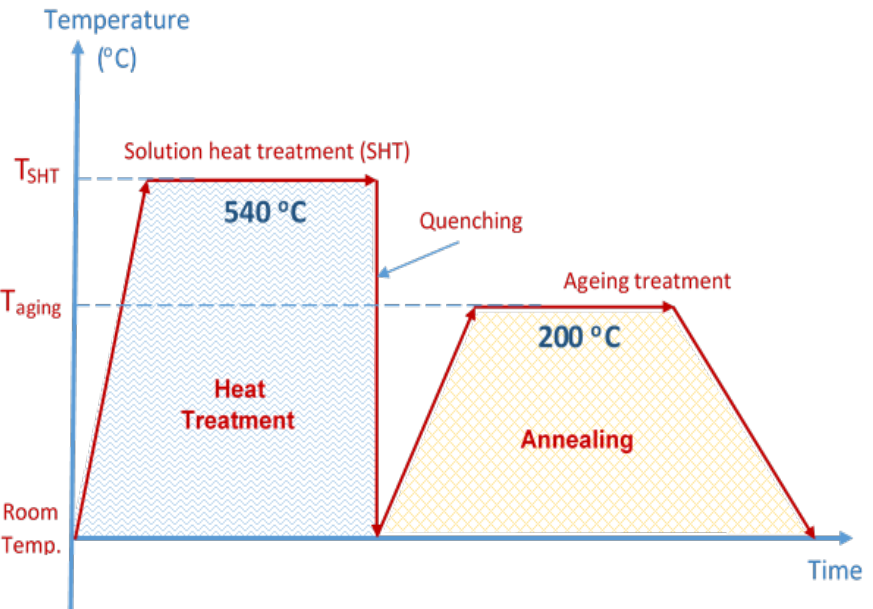
Figure 1. Alloys Before and after rolling.